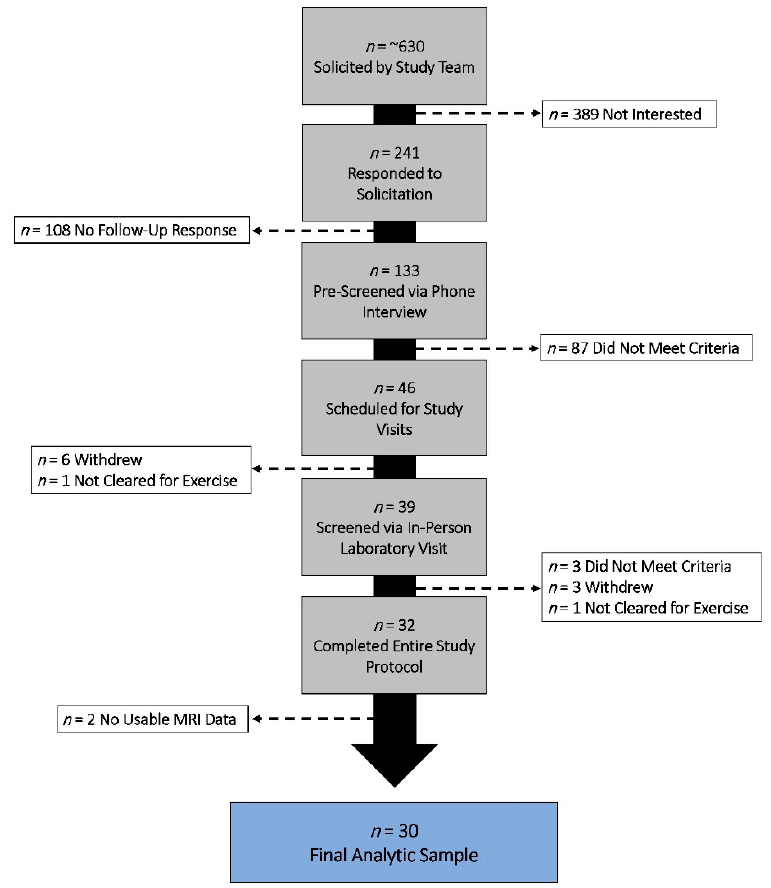
Figure 1. Participant recruitment, screening, exclusion, and enrollment between 2016 and 2018.